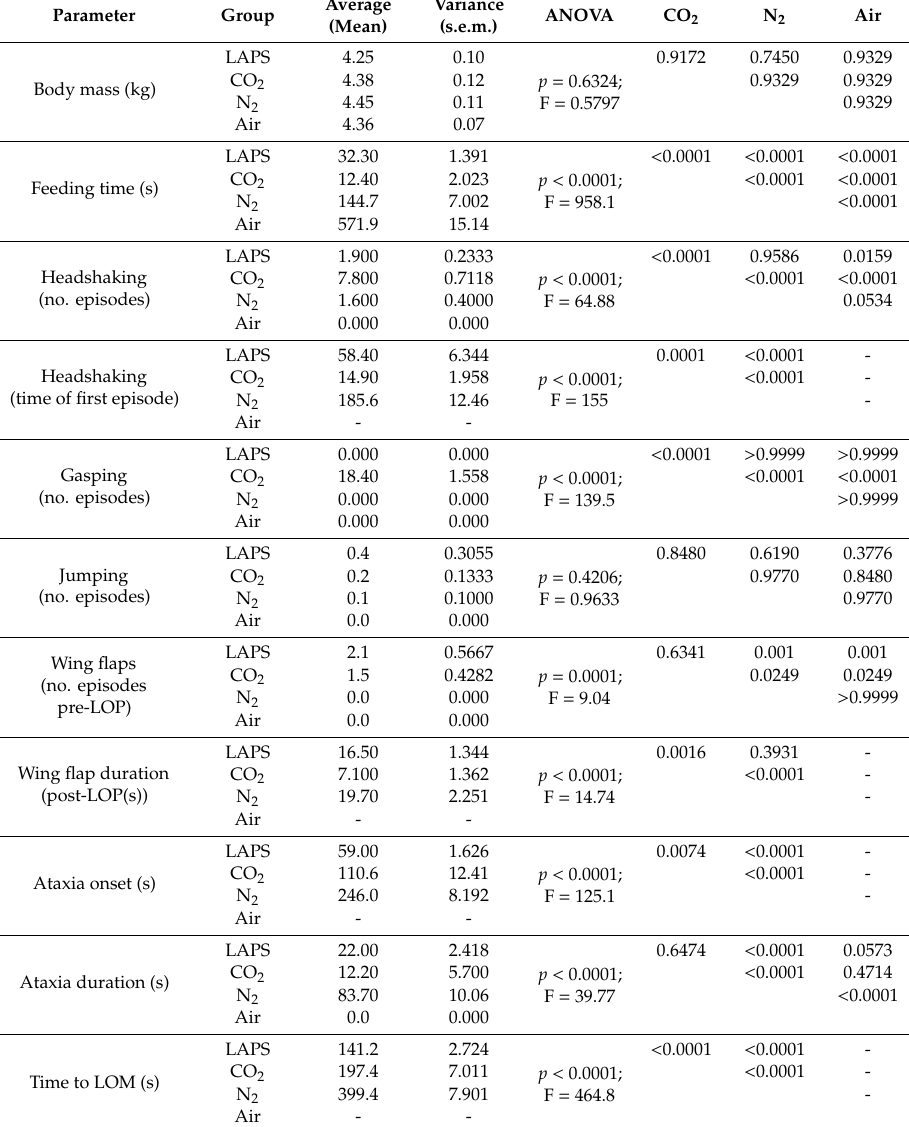
Table 1. Quantification of Behavioural